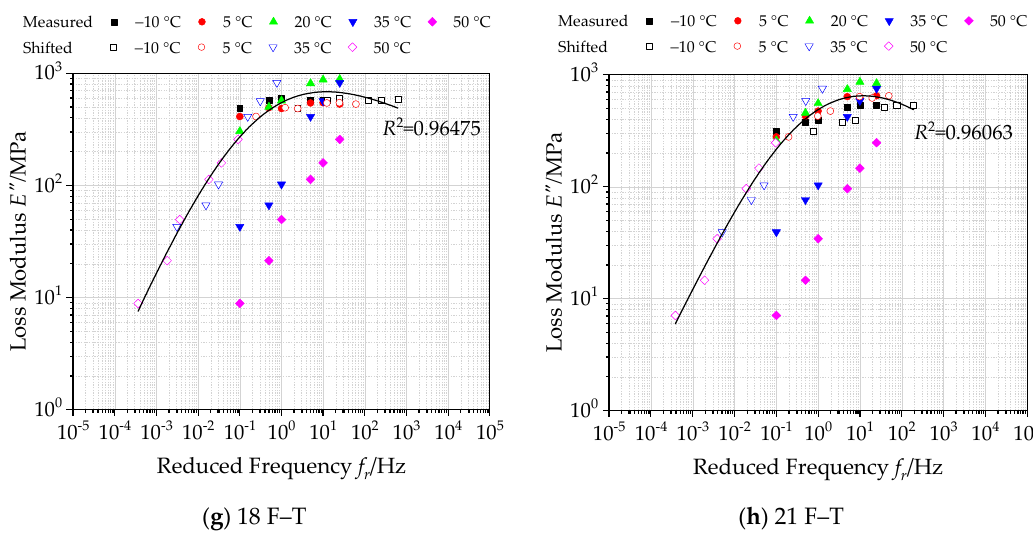
Figure 11. Master curves of loss modulus under various F–T cycles (reference temperature = 20 °C). Table 10. Parameters of master curve functions of loss modulus under various F–T cycles.